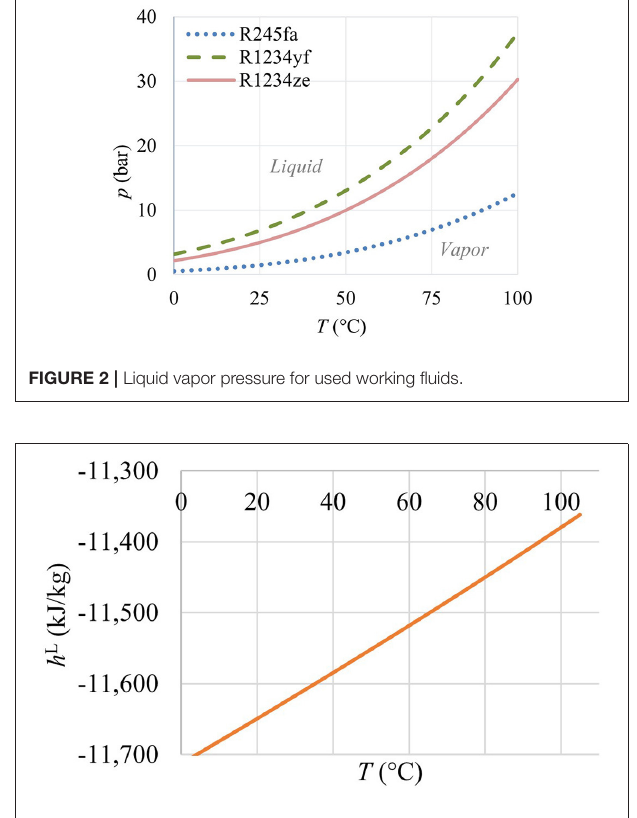
FIGURE 3 | Liquid mass enthalpy of ethylene glycol-water mixture.